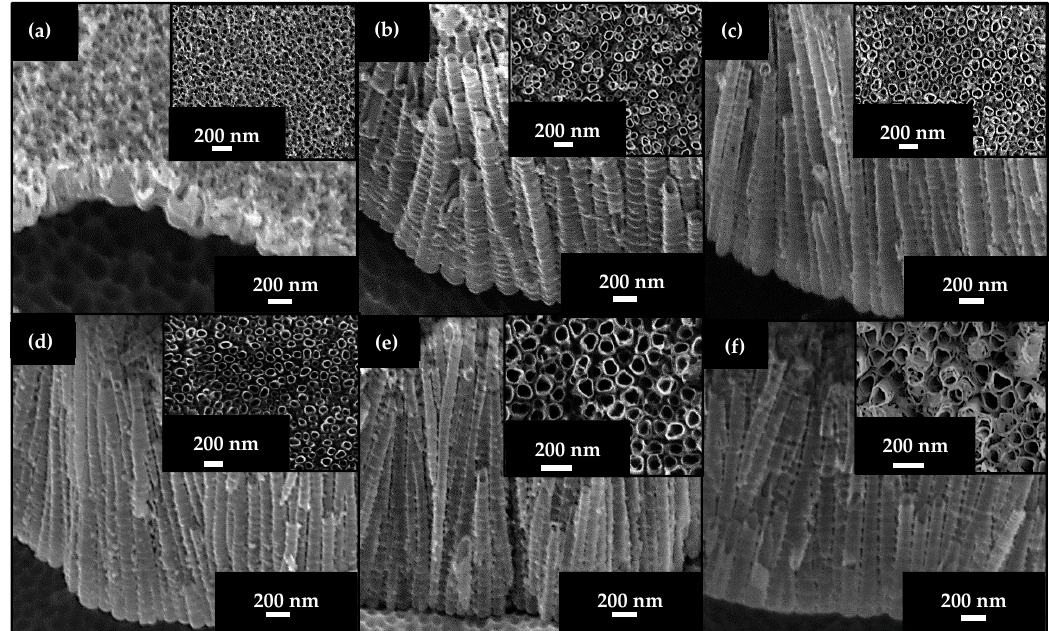
Figure 1. FESEM of anodized TiO 2 at 20 V for 90 min in the glycerol–water electrolyte with different NH 4 F concentrations: ( a ) 0.1, ( b ) 0.3, ( c ) 0. 5, ( d ) 0.7, ( e ) 0.9, and ( f ) 1.0 wt.%.